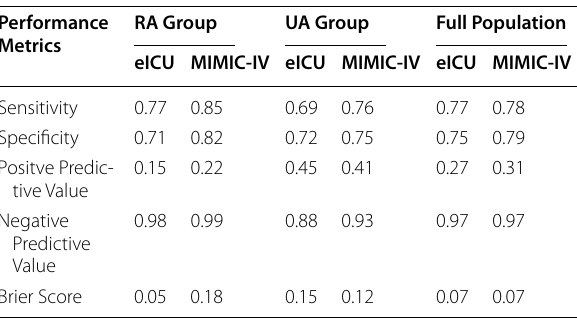
Table 1. 5-fold Median Performance Metrics for Population Groups. Conclusion. In patients admitted to the ICU with a